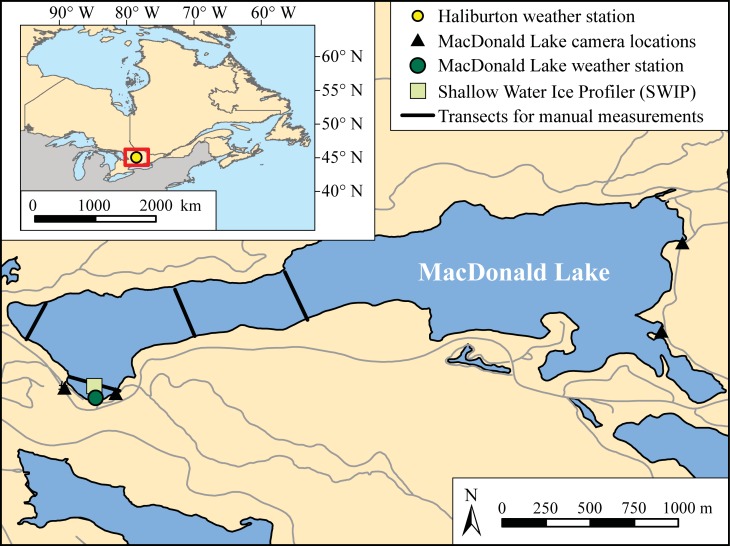
MacDonald Lake in the Haliburton Forest and Wildlife Reserve Ltd.Property, the dark green dot indicates the location of the on-shore weather tower; the light green square is the location of the Shallow Water Ice Profiler, placed less than 30 metres off-shore in view of the weather tower; the black triangles show the location of shoreline cameras used for observing daily ice conditions; and the black lines represent the transects where manual ice thickness measurements were collected. The location of the Haliburton weather station (yellow circle), which is the location for the homogenized long-term temperature data, is shown.